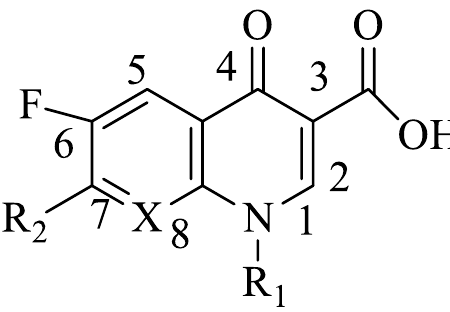
Figure 1. Maternal structure of fluoroquinolones (FQs). R 1 is a hydrocarbon group usually, R 2 is usually a piperazine ring, X is carbon or nitrogen.